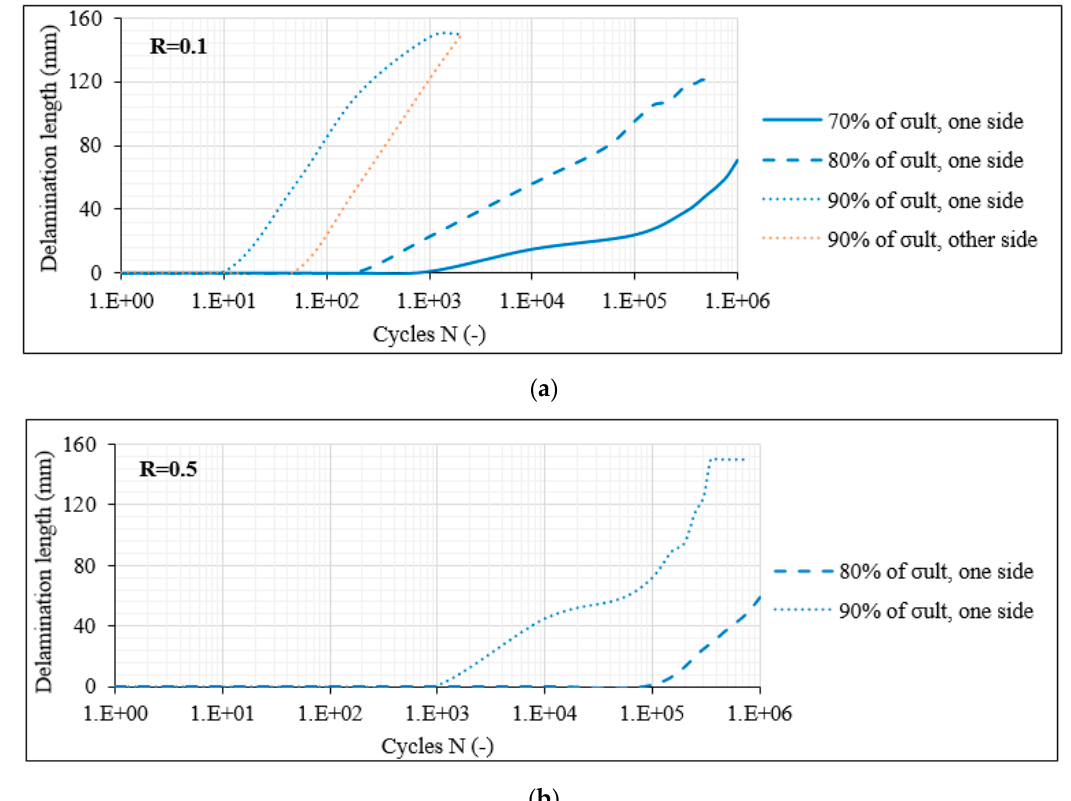
Figure 10. Delamination crack growth versus N in [0°/60°] 2s laminates for ( a ) R = 0.1 and ( b ) R = 0.5.